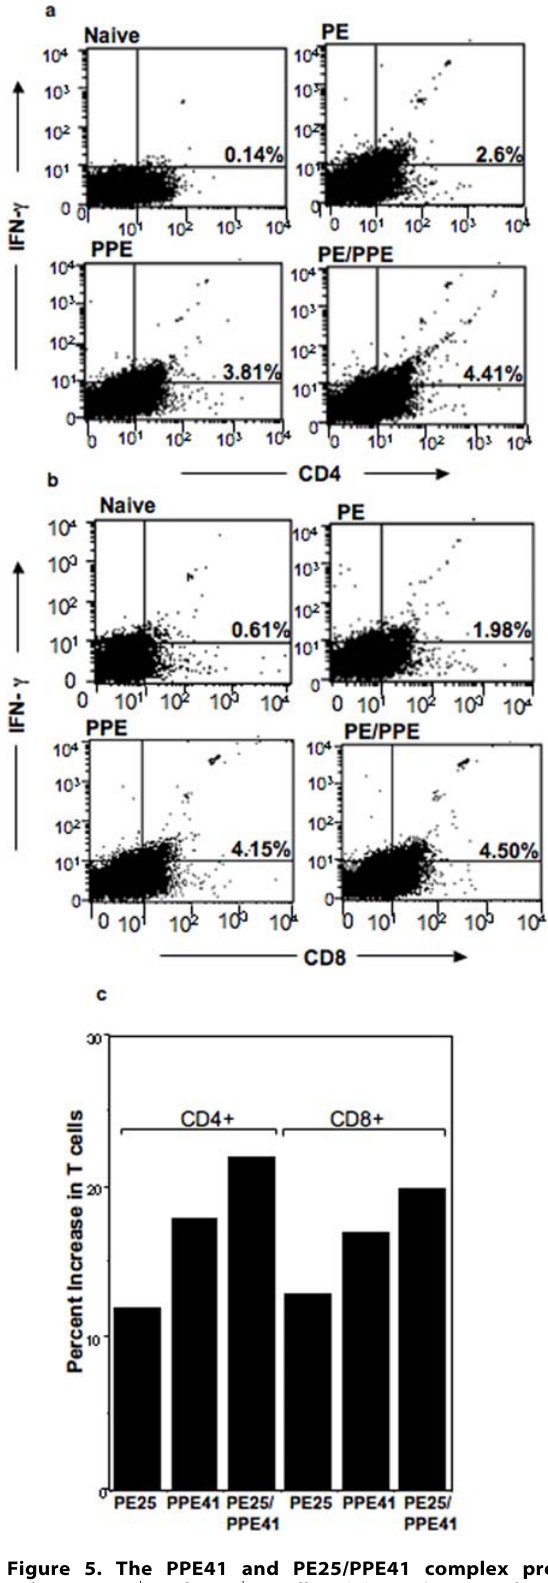
Figure 5. The PPE41 and PE25/PPE41 complex proteins enhance CD4 + and CD8 + T cell activity. Splenocytes from naı¨ve mice or mice immunized with each of the recombinant proteins (PE25, PPE41 and PE25/PPE41) were stimulated with different concentration of the corresponding proteins in-vitro . The intracellular IFN- c secreted